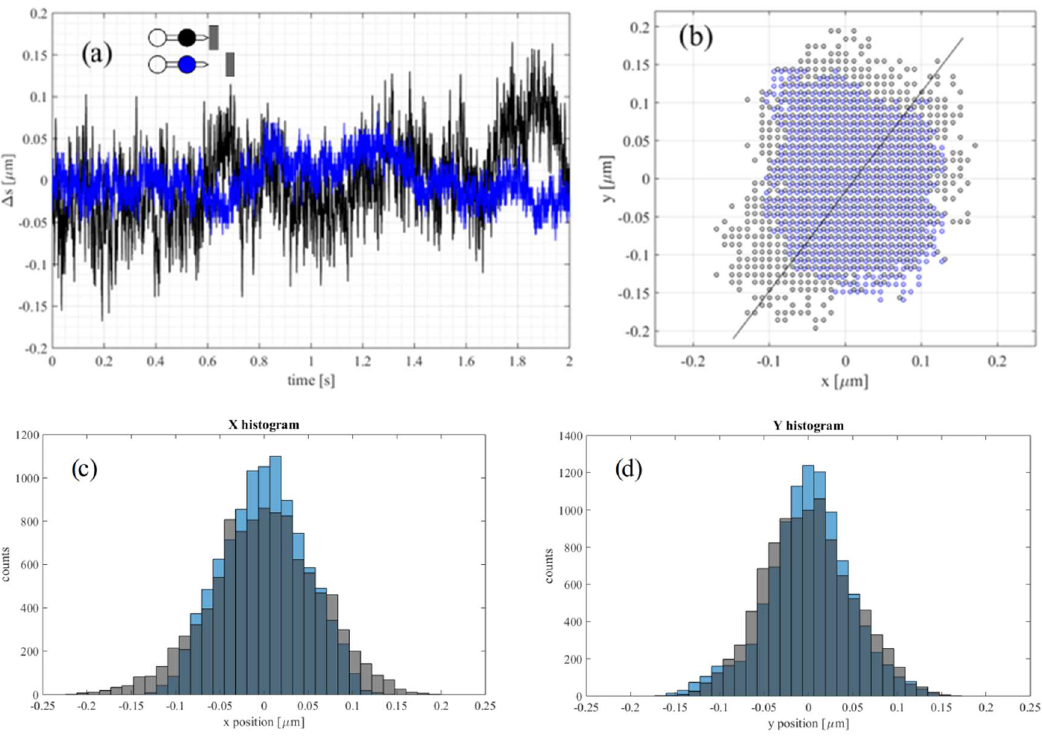
Figure 9. Vibrations measurements in microscale. ( a ) Displacement of the front bead for the trapped micro-tool in contact (black) and not in contact (blue) with the cotton fiber. The two measurements were performed in different two-second intervals and are presented on the same plot for comparison; ( b ) corresponding position of the front bead in the x-y plane (the sample plane) measured every 0.2 ms. The alignment of the micro-dumbbell in the x-y plane corresponds to the one in Figure 8. A solid black line indicates the direction along which histograms in ( c , d ) were calculated; ( c , d ) histograms of the x and y positions of the bead along the line from ( b ). Blue bins correspond to blue points, gray bins to black points and the dark grey color is the overlapping region.